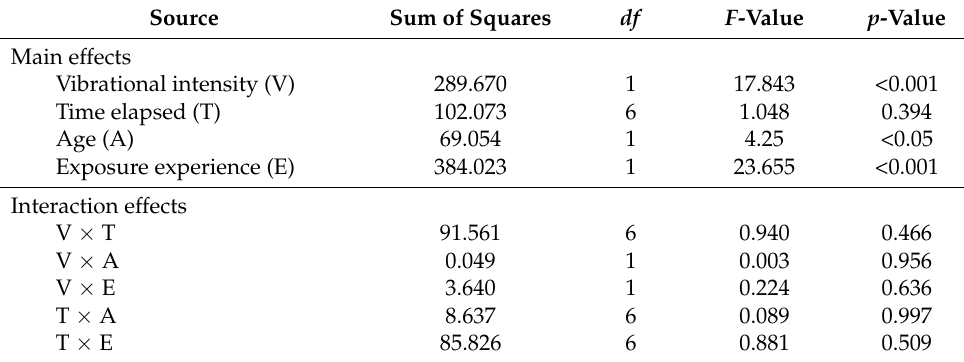
Table 6. Parameters of TTS recovery calculated from the vibrotactile perception test performed after exposure to high HAV.